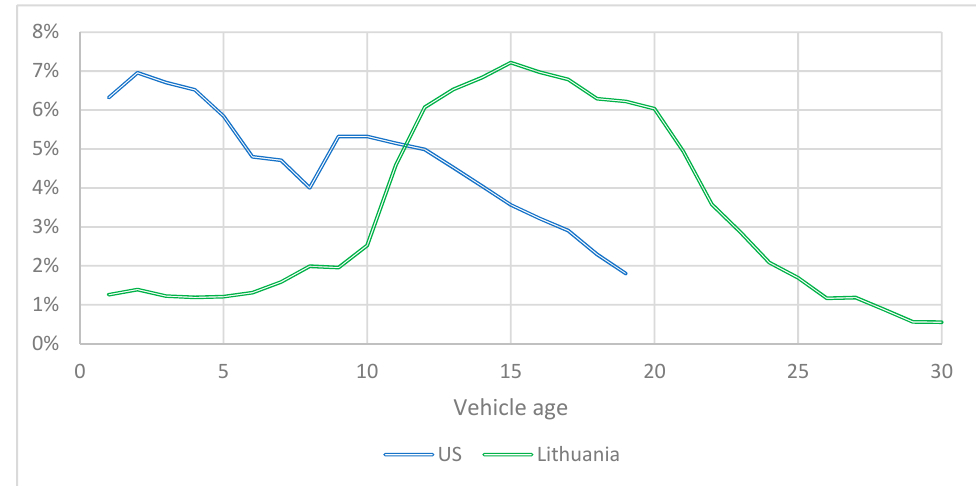
Figure 1. Passenger car age distribution in the US and Lithuania [32,33].